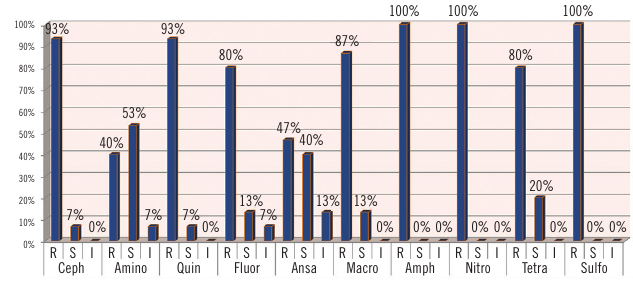
figurE 2 − Resistance and antimicrobial susceptibility profiles of Enterobacter sp. isolated from PU exudate among internal medicine inpatients, Petrolina (PE) Enterobacter sp. is intrinsically resistant to penicillin; hence it was not necessary to test this antimicrobial.